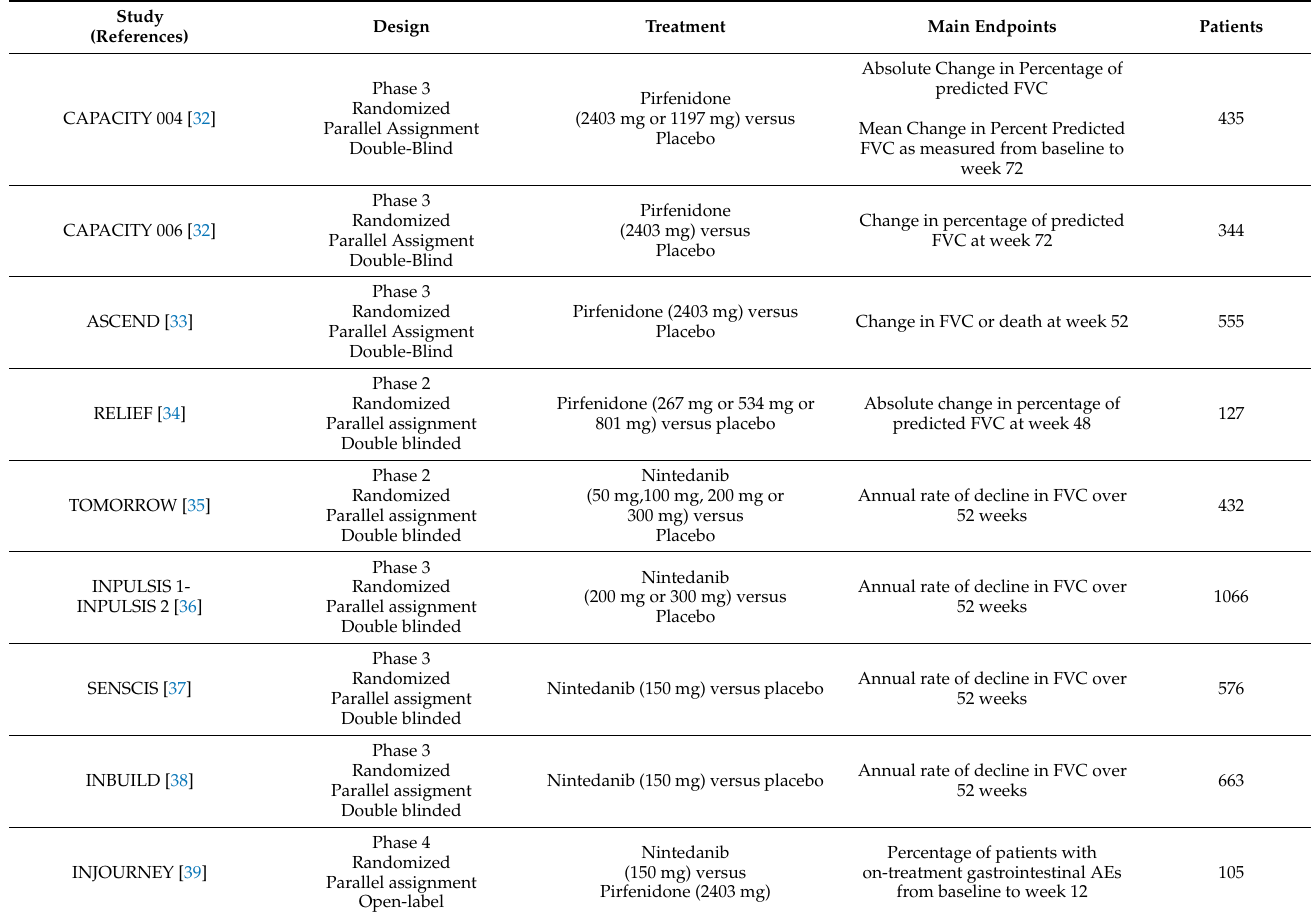
Table 1. Main clinical trials on pirfenidone and nintedanib in idiopathic pulmonary fibrosis